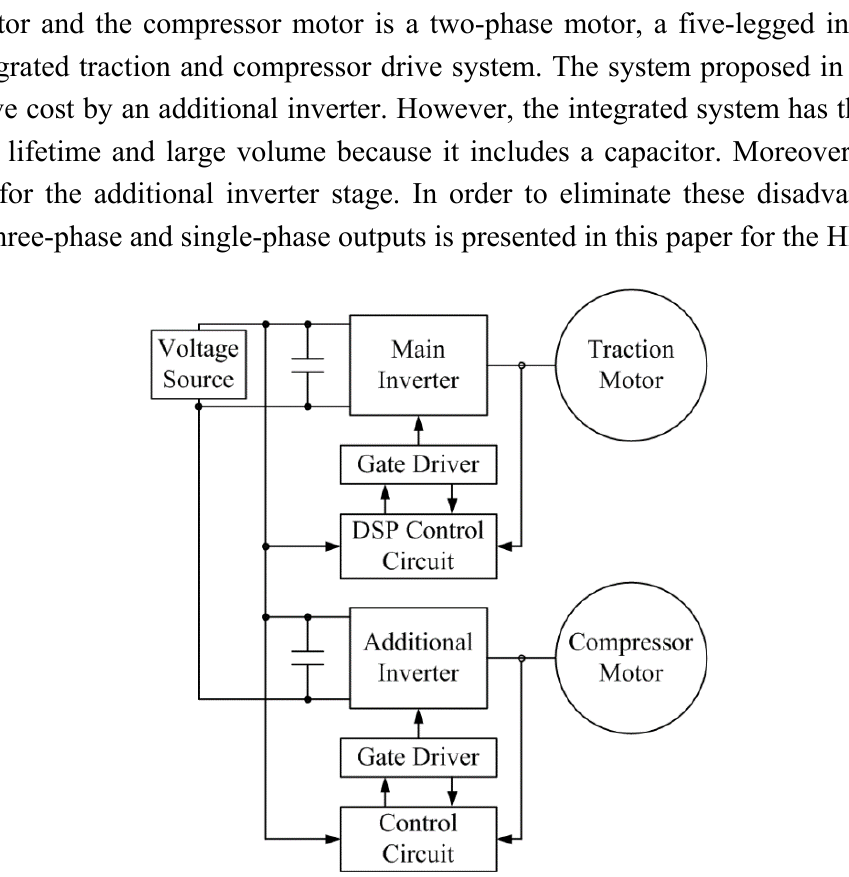
Figure 2. Conventional traction and compressor motor drive system using two separate